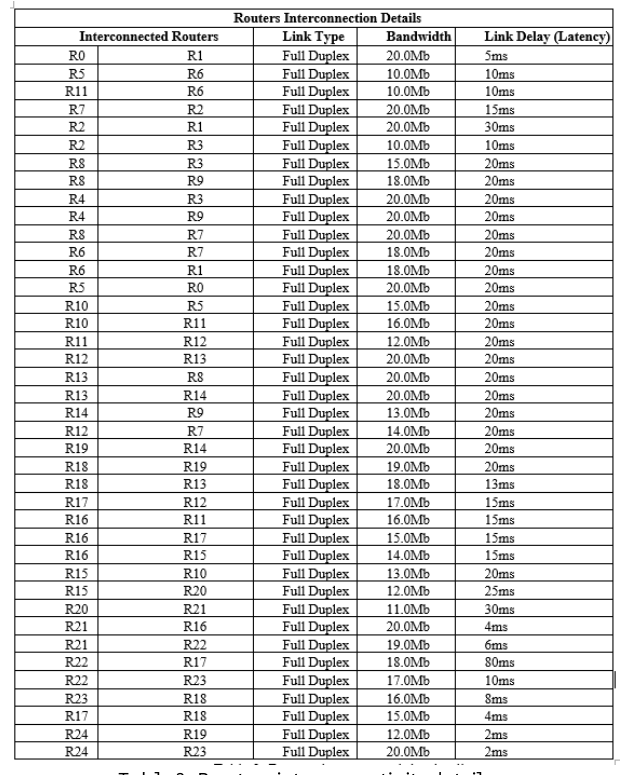
Table 3: Routers interconnectivity details